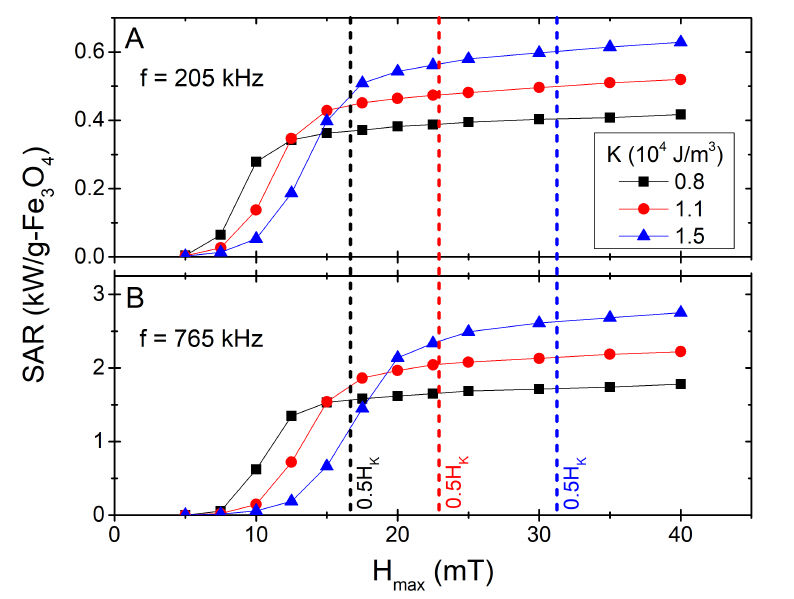
Figure 5. SAR vs. H max for the three K values (at corresponding d aggl ), for f = 205 and 765 kHz (( A ) and ( B ) panels, respectively). The vertical lines stand for half of the anisotropy field of each K value (of same